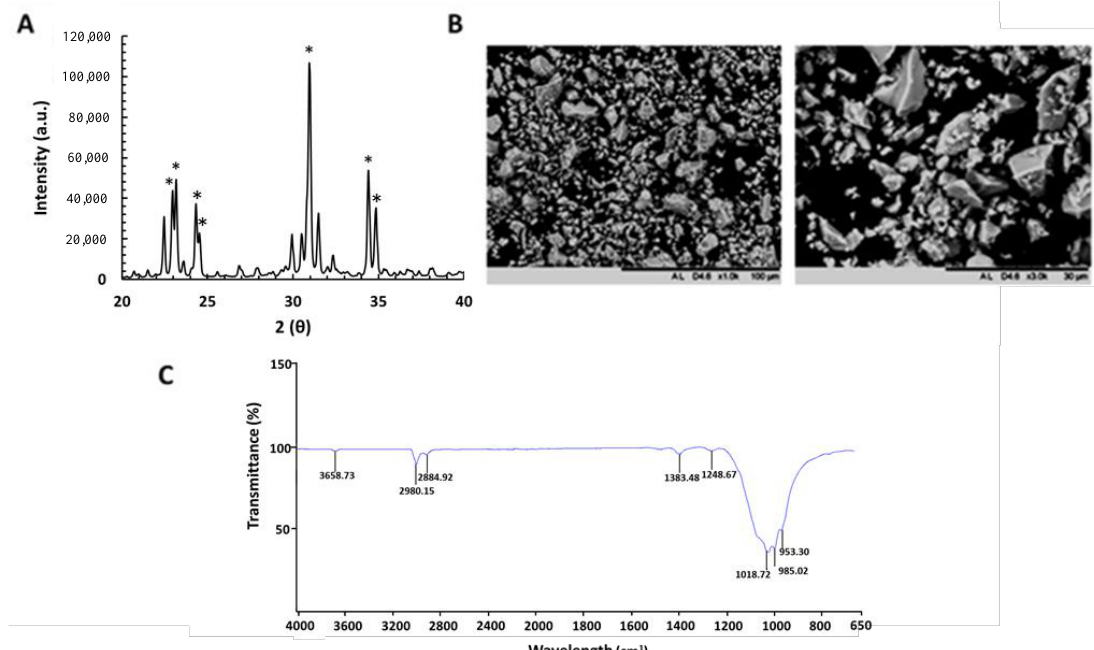
Figure 1. Chemical and morphological characterization of alpha-tricalcium phosphate ( α -TCP) powder. ( A ) representative XRD pattern of α -TCP exhibiting characteristic peaks; ( B ) FTIR spectra of α -TCP; and ( C ) SEM micrographs of the surface of α -TCP after final milling step show that the granules of α -TCP have an irregular-shaped morphology. (Scale bar = 100 µ m; scale bar = 30 µ m), (N = 3 ±